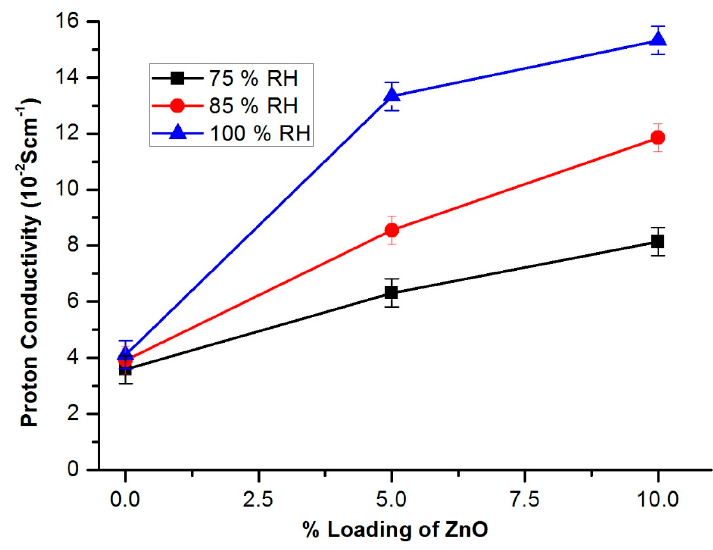
Figure 12. Proton conductivity curves for the various ZnO NP loaded membranes.